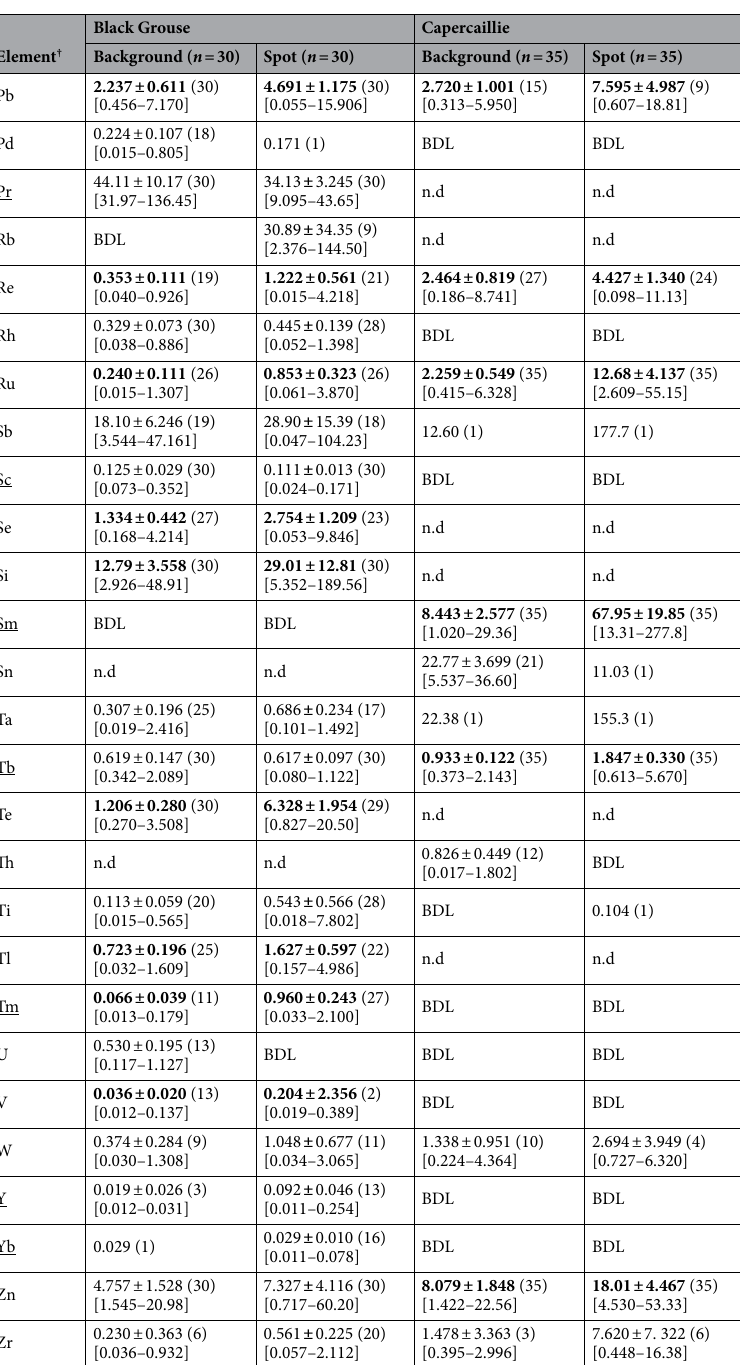
Table 1. Average (± 95% CI) elemental concentrations (ppm d.w.) measured by ICP-OES in two adjacent eggshell regions with contrasting colour patterns, i.e. background colour and pigment spots, over all the eggs/ eggshells of Black Grouse Tetrao tetrix and Capercaillie Tetrao urogallus ; the number of samples above the detection limit and ranges are given in round and square brackets, respectively; BDL—all samples below the detection limit; n.d.—not determined; significant differences (ANOVA, P ≤ 0.05) in elemental concentrations measured in the background colour and pigment spot regions over all eggshells are shown in bold. The results of the paired comparison of background-spot elemental concentrations for the same eggs are listed in Tables S5 and S6. † Rare earth elements (REEs) are